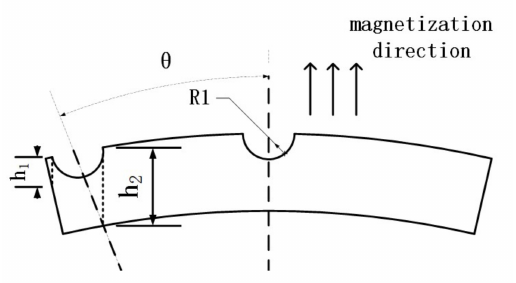
Figure 9. Schematic diagram of magnetization length change after